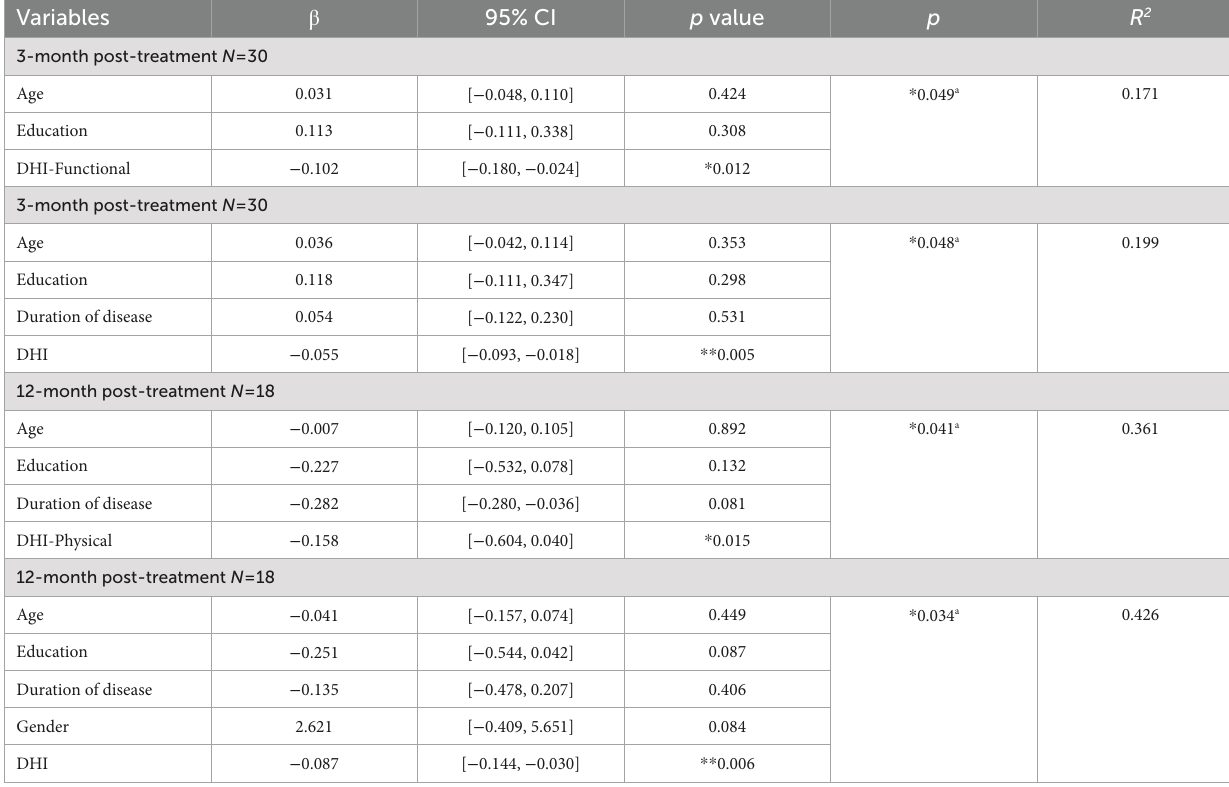
TABLE 7 Regression analyses of improvements in MoCA scores and